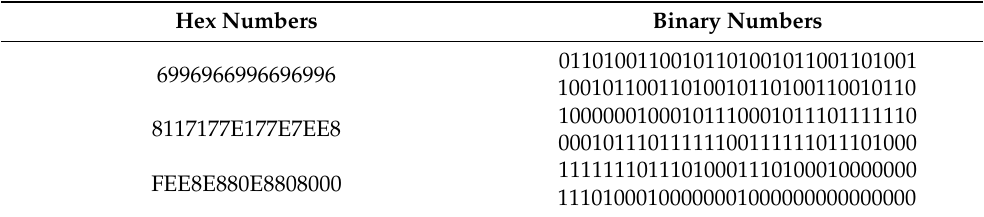
Table 2. The initialization contents of three